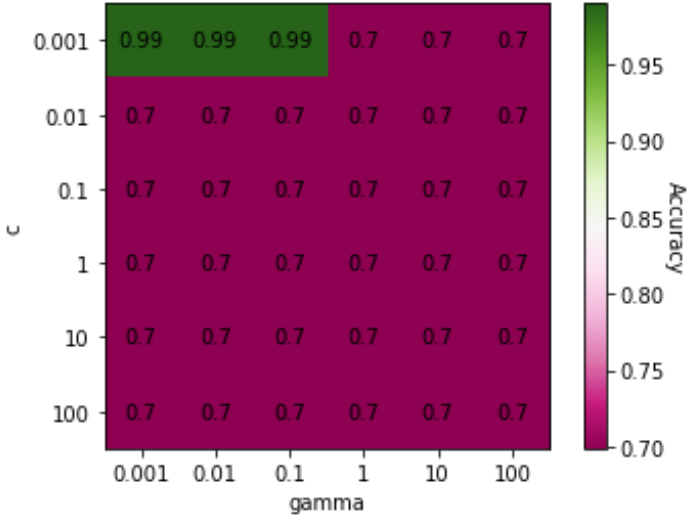
Table 5. Classification results for Dataset 02 (COPD/control).